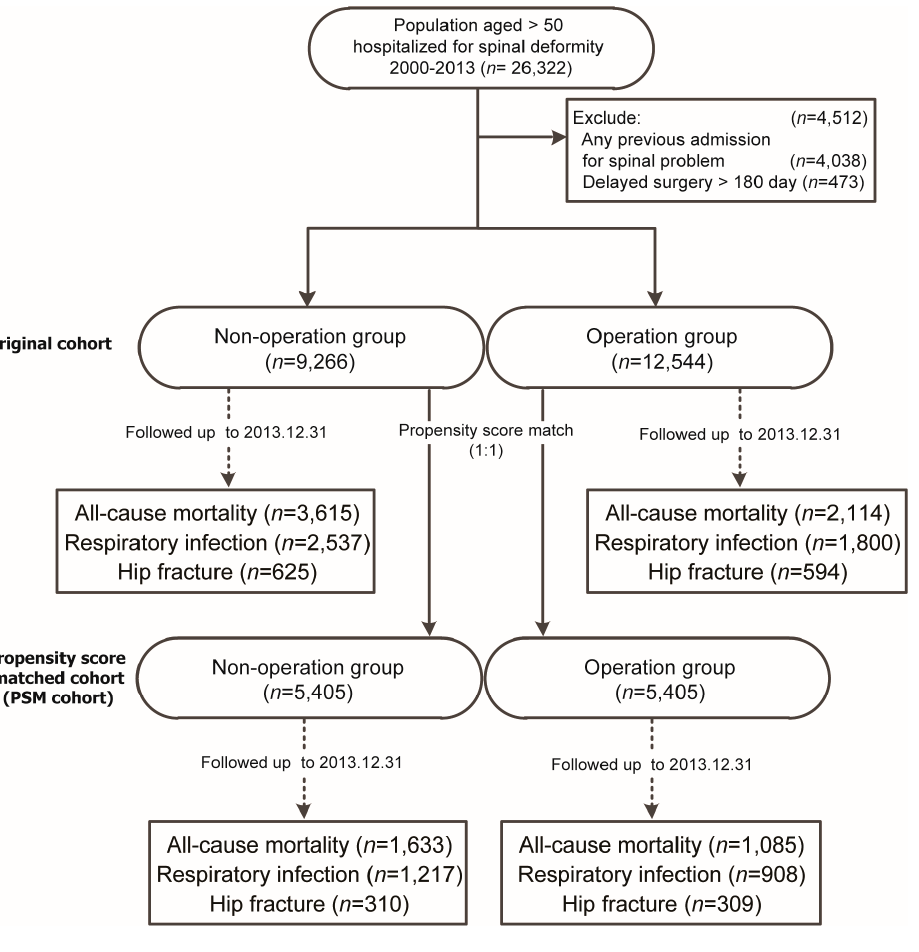
Figure 1. Flowchart of data processing for outcomes of a cohort with degenerative spinal deformity (DSD), with a subgroup analysis of patients from both groups and who were matched with propensity scores. DSD patients in Taiwan, 2000–2013 ( n = 26,322).